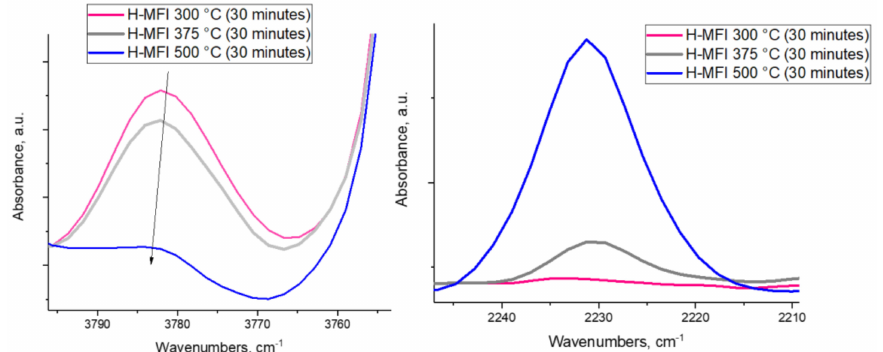
Figure 2. FTIR spectra of steamed H-MFI sample (all spectra were collected on the same pellet) ( Left ) OH region showing the diminishment of the ~3780 cm − 1 band with temperature (spectra were recorded at room temperature). ( Right ) FTIR final spectra collected after introducing a total of 1 Torr of CO (total pressure, room temperature) on the steamed H-MFI sample after each thermal treatment and decreasing to room temperature. The development of Al-CO spectra sequentially during in-situ N 2 and CO adsorption is shown in Figure 4.